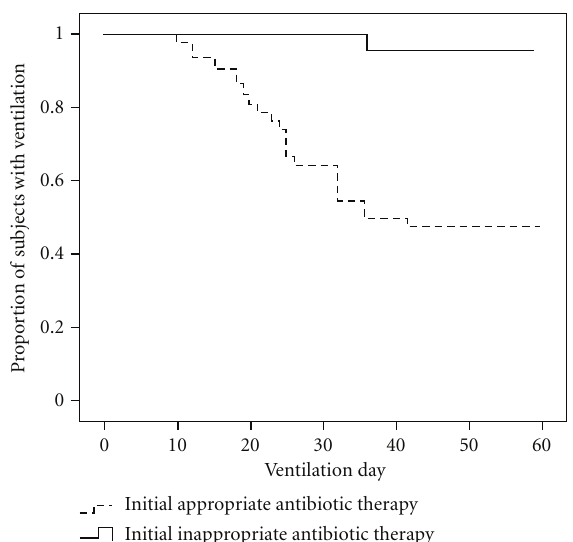
Figure 2: Kaplan-Meier curve showing the proportion of patients with ventilation over time according to initial appropriate or inappropriate antibiotic